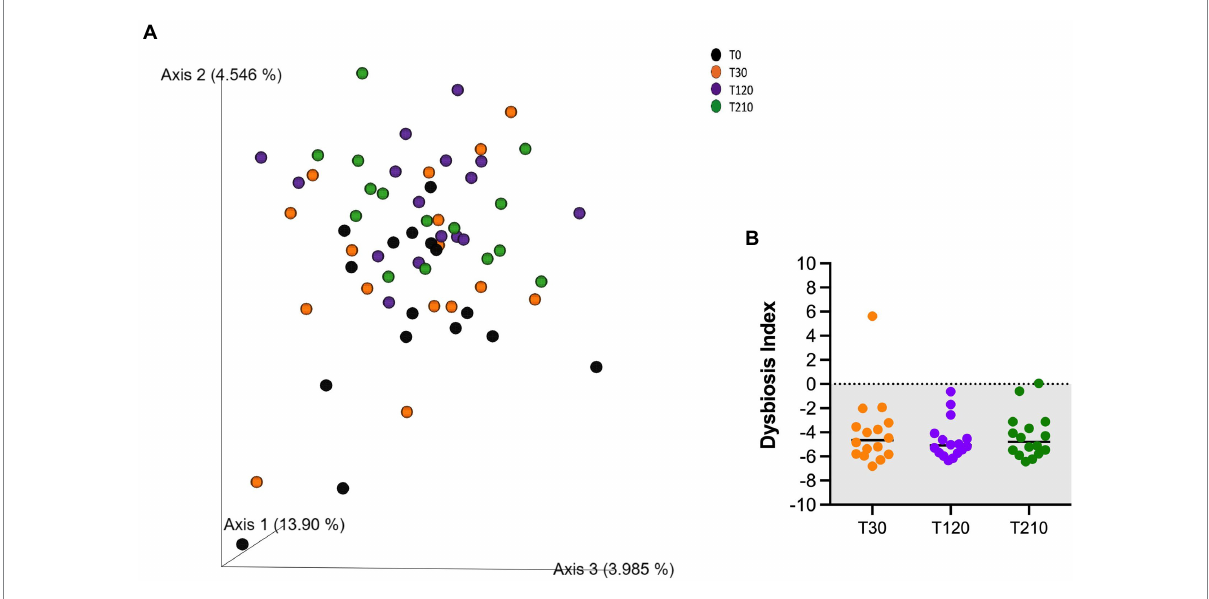
FIGURE 4 (A) PCoA plot based on the unweighted UniFrac distance metric of the fecal microbiota of obese dogs. Differences before (T30) and after 90 and 180 days of caloric restriction were not observed ( p > 0.05). (B) qPCR-based fecal Dysbiosis Index of obese dogs before (T30), after 90 days (T120) and at the end (T210) of caloric restriction. Negative values (the grey area) are indicative of a health microbiota, while values between 0 and 2 are considered equivocal.